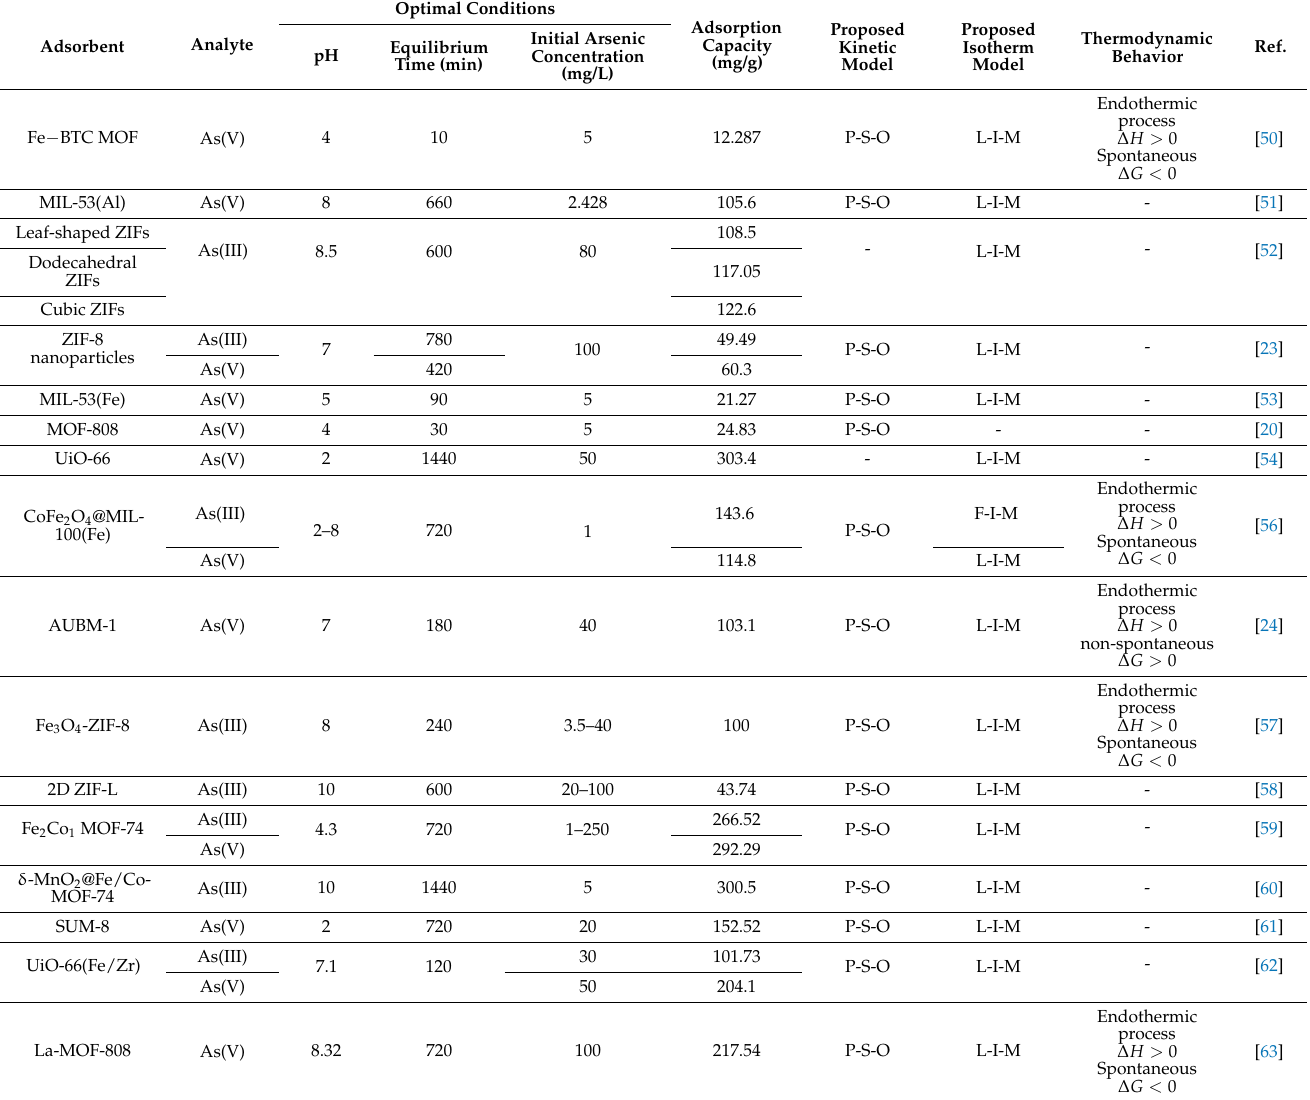
Table 1. Comparison MOFs used for arsenic removal from the aquatic environment in the last decade. The Table is sorted based on the year in which the synthesized MOFs were